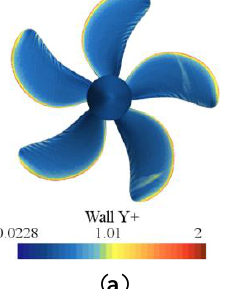
Figure 8. y + distribution on suction side surface of propeller Kap00 ( a ), Kap02 ( b ) and Kap04 ( c ) ( J = 0.8, 12